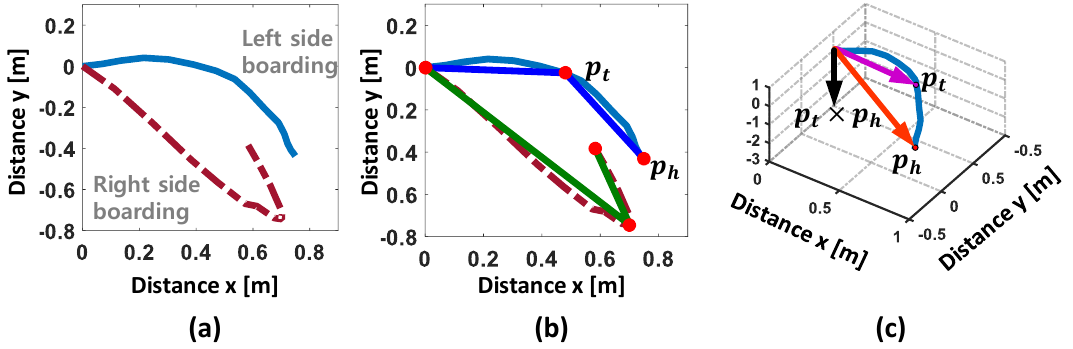
Figure 3. Process of boarding direction classification: ( a ) moving trajectories; ( b ) computing representative points by applying line approximation; ( c ) determining the boarding direction by computing ppp t × ppp h